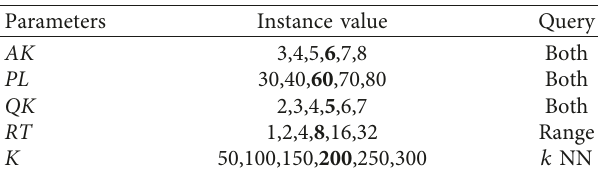
Table 4: The query